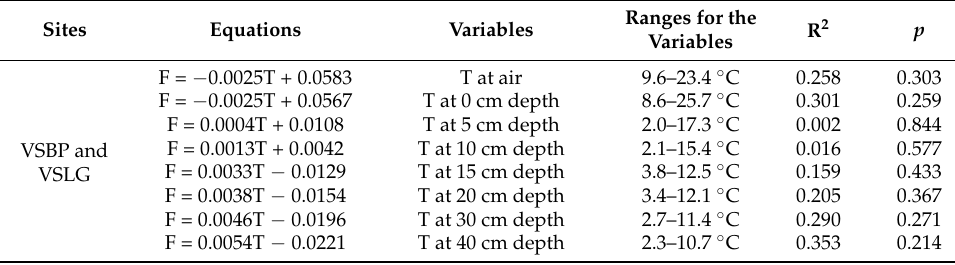
Table 2. Relationships between N 2 O fluxes, air and soil temperatures within the different vegetation types within